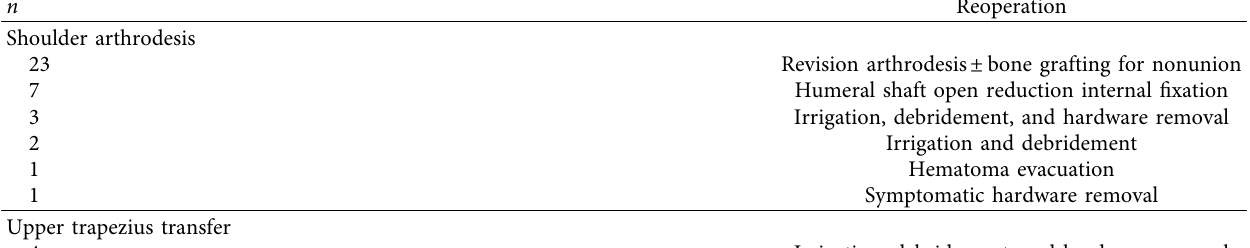
Table 4: Reoperations following shoulder arthrodesis and upper trapezius transfer.